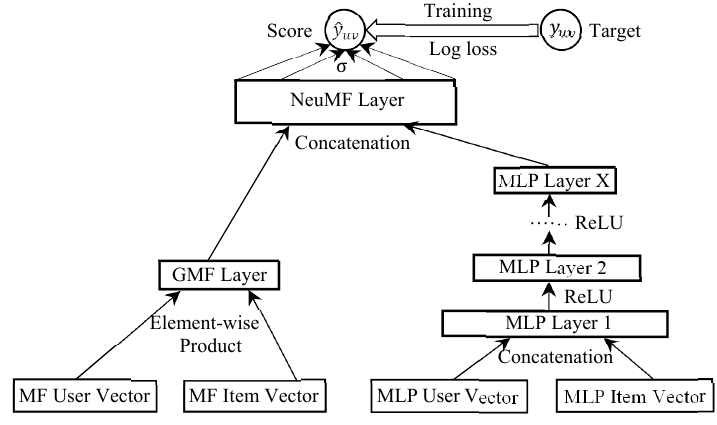
Figure 2. The structure of NeuMF [1].